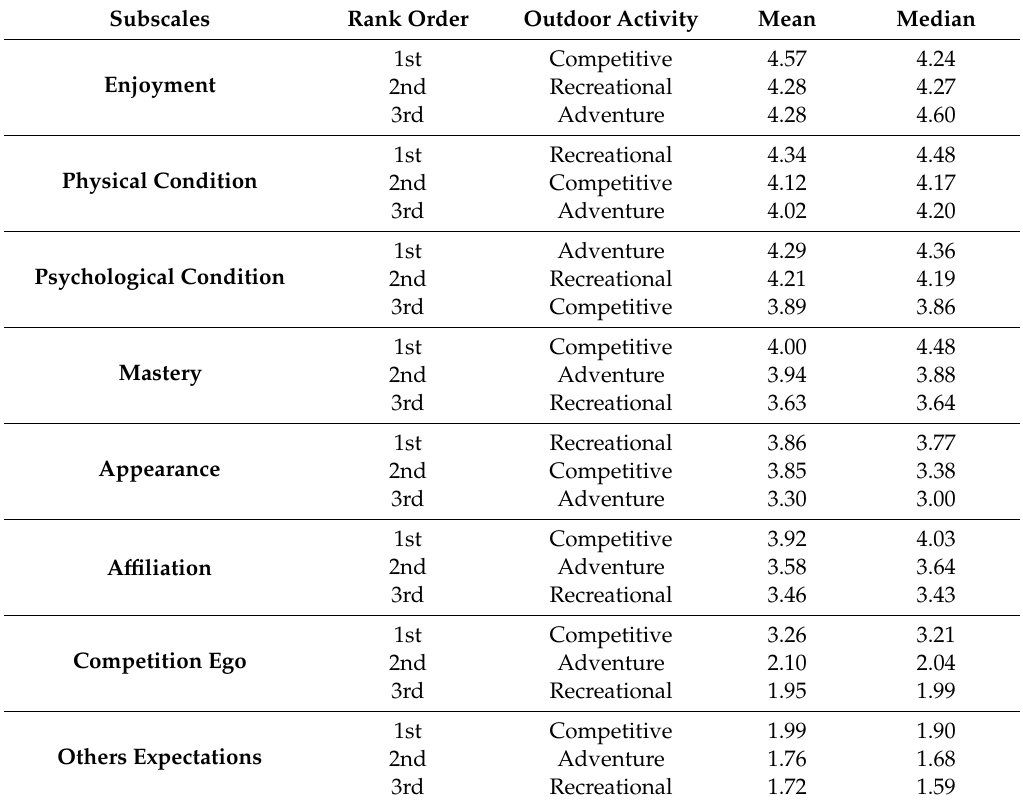
Table 3. Ranking of participation motives for type of green